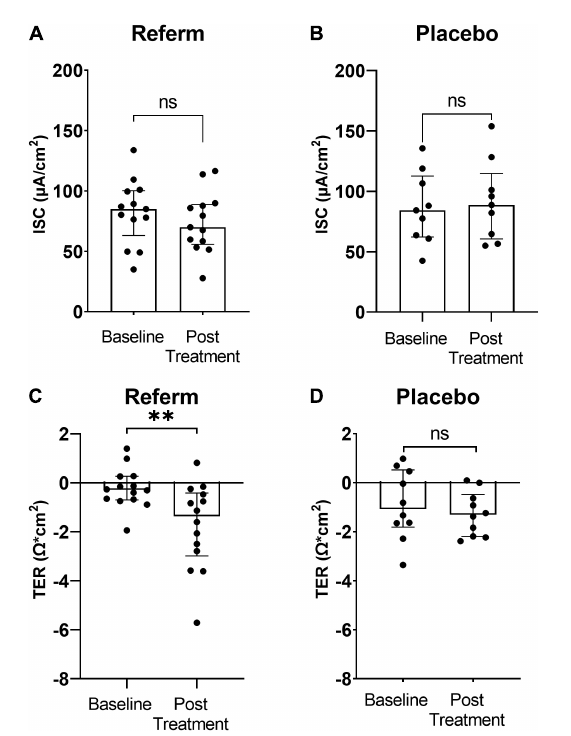
FIGURE2 The effect of fermented oat gruel (ReFerm R (cid:13) ) or placebo interventions on short-circuit current (Isc) and transepithelial resistance (TER) in irritable bowel syndrome (IBS). Patients with IBS were allocated to the ReFerm R (cid:13) arm ( n = 18) or the placebo arm ( n = 12). Biopsies were collected at baseline and after the intervention. (A) Isc at baseline and after ReFerm R (cid:13) treatment. (B) Isc at baseline and after placebo intervention not significant (ns). (C) TER, difference 30–90 min at baseline and after ReFerm R (cid:13) treatment ∗∗ p < 0.01. (D) TER, difference 30–90 min at baseline and post placebo intervention. Data are presented as the median and interquartile range (IQR). n , number of